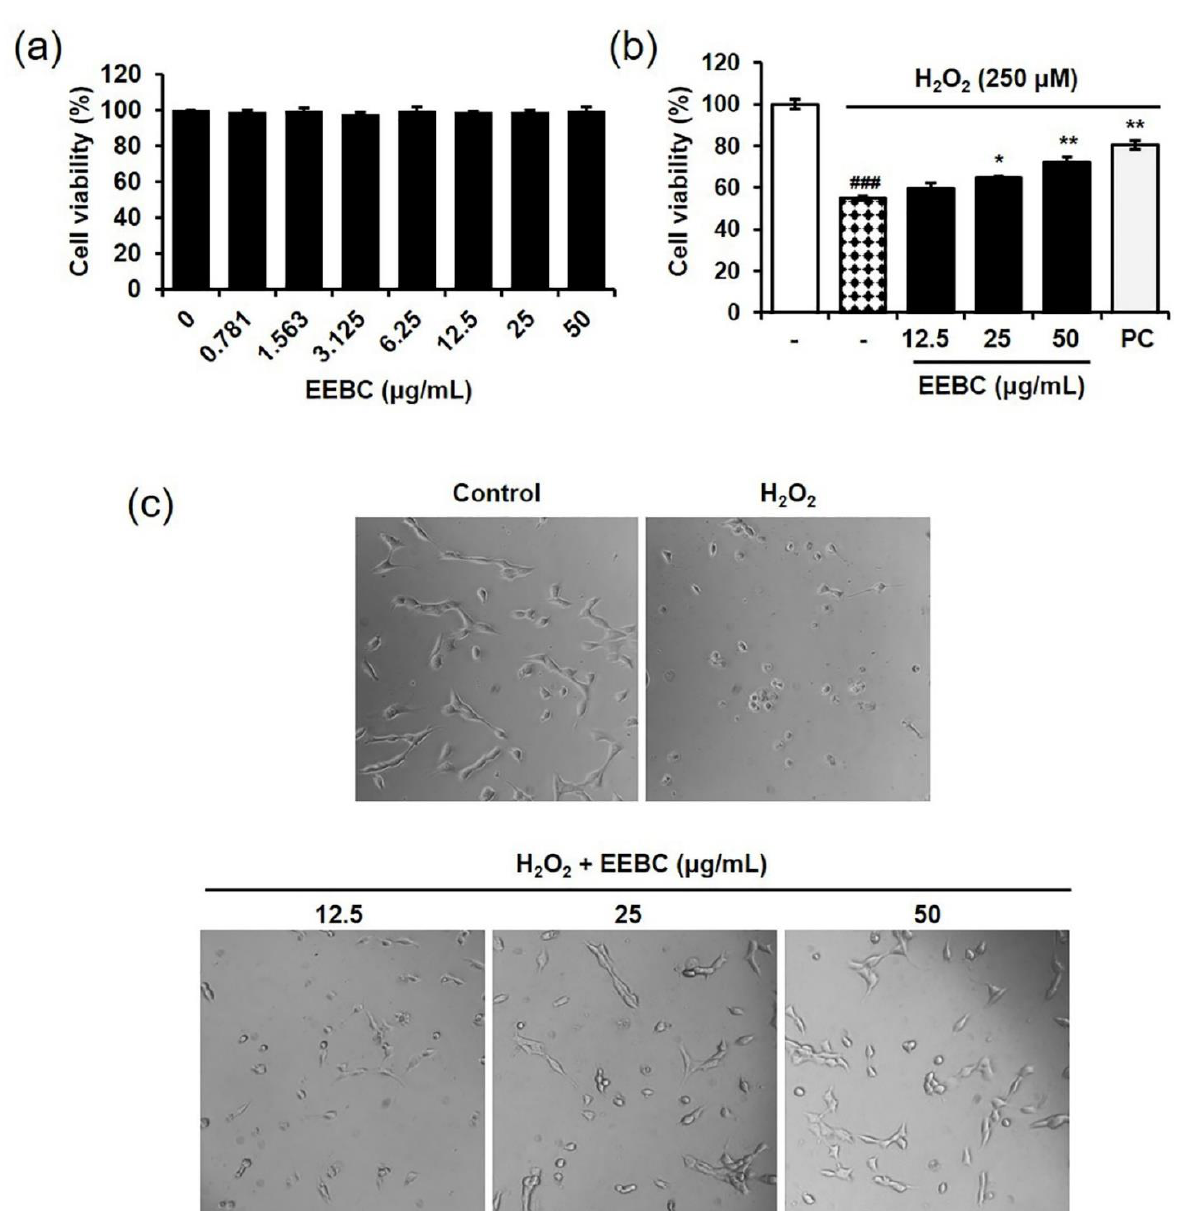
Figure 2. Protective effects of EEBC against H 2 O 2 -damaged HT22 neuronal cells. ( a ) Cells were incubated with various concentrations of EEBC for 24 h and cell viability evaluated using a Cell Counting Kit (CCK) assay; ( b ) Cells were co-treated with EEBC (0, 12.5, 25, or 50 μg/mL) and H 2 O 2 (250 μM) for 6 h. CCK assay was performed to assess changes in cell viability. Caveolin was used as a positive control. Data are expressed as % of the control. Values represent mean ± SEM. ### p < 0.001 vs. untreated cells; * p < 0.05 and ** p < 0.01 vs. H 2 O 2 -treated cells; ( c ) Morphological changes in cells were observed under inverted microscopy (Eclipse TS100, Nikon, Japan). EEBC: ethanol extract of B. coccinea branches. CCK: Cell Counting Kit. PC: positive control.